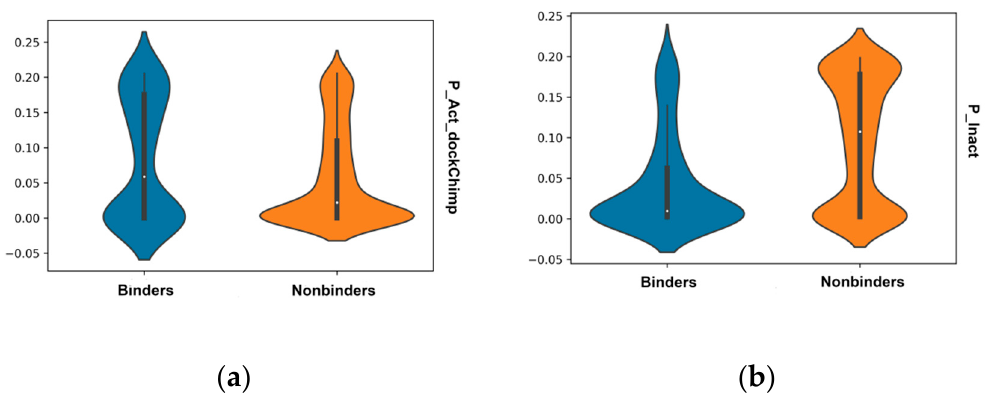
Figure 2. Violin plots for the distributions of Bayesian probabilities for docking scores for: ( a ) binders (P_act_dockChimp); and ( b ) nonbinders (P_Inact) for chimp androgen receptor docking scores for binders (blue) and nonbinders (orange).